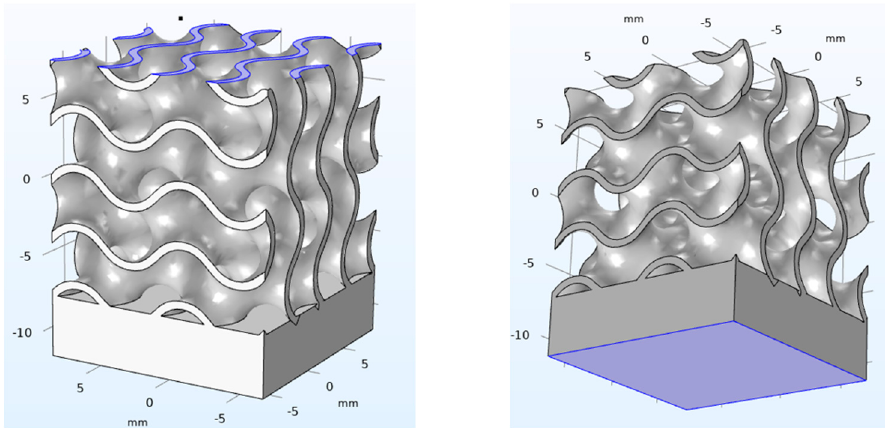
Figure 2. Boundary conditions applied at the upper and lower surface of each virtual specimen.